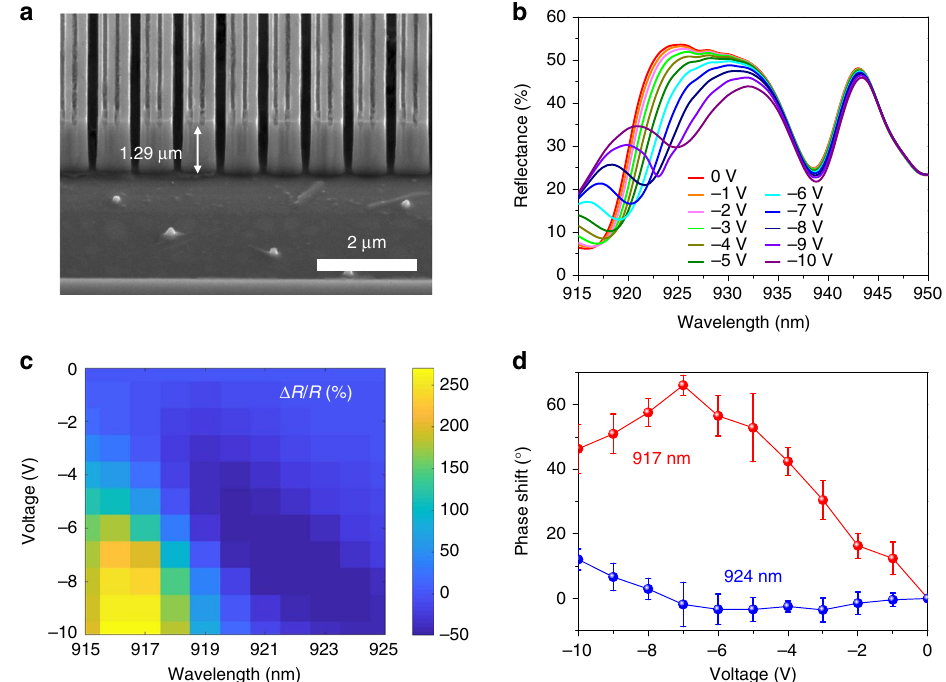
Fig. 3 Experimental veri fi cation of optical modulation in MQW resonators. a SEM image of MQW-based hybrid Mie-GM resonators with double slits. b Measured re fl ectance spectra of the resonator array for different applied bias voltages. The incoming light is polarized perpendicularly to the MQW stripes. c Measured relative re fl ectance of the hybrid Mie-GM resonant metasurface as a function of wavelength and applied voltage. We consider the wavelength range from 915 nm to 925 nm with a step of 1 nm. d Measured phase modulation at two different wavelengths. Red: 917 nm, blue: 924 nm. Each data point corresponds to an average phase shift measured at four different positions on the sample, while each error bar indicates the standard deviation of the obtained four data